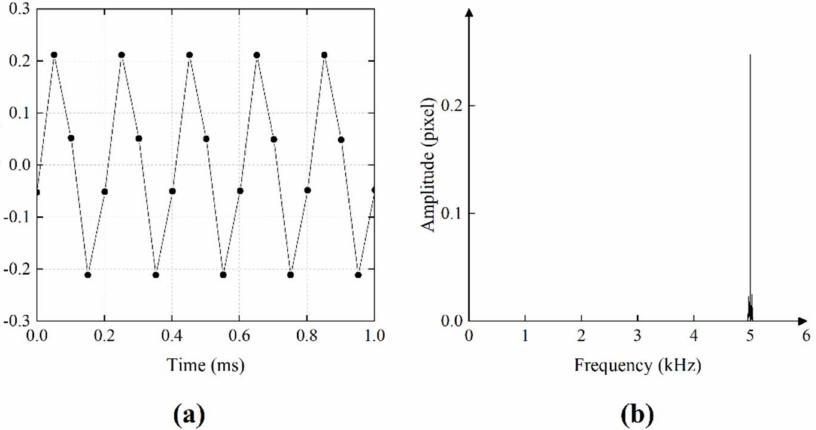
Figure 11. ( a ) The first 1 ms of restored temporal signal; the original signal frequency was 5 kHz. ( b ) Spectrogram of the restored audio